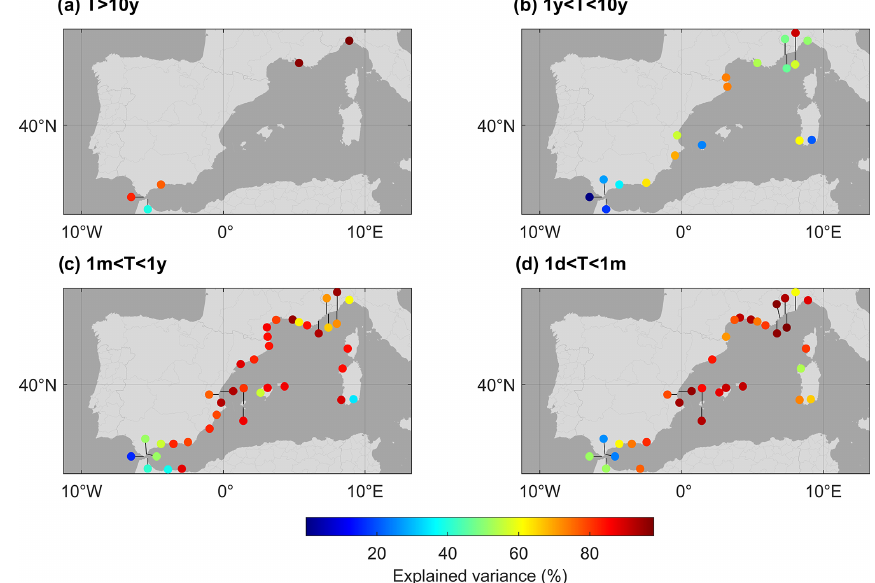
Figure 3. Percentage of variance in the original tide gauge series explained by the reconstructions for the four frequency bands: (a) T > 10 y